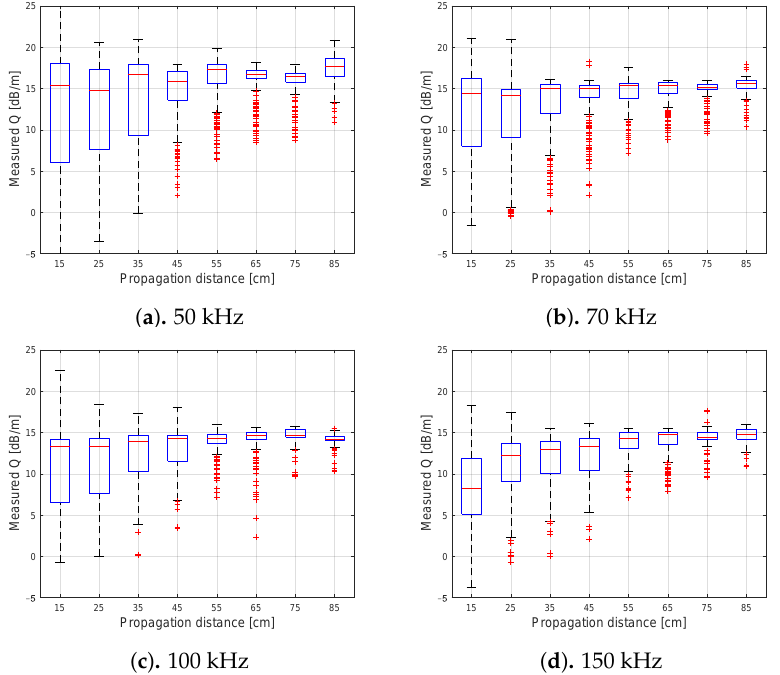
Figure 7. Estimated and sorted attenuation rates Q along the water-sand transition. The data contains all measured circumferential FA-L(0,1) of ring number two and the four excitation frequencies. The data is sorted and selected as blocks according to the propagation distance of each